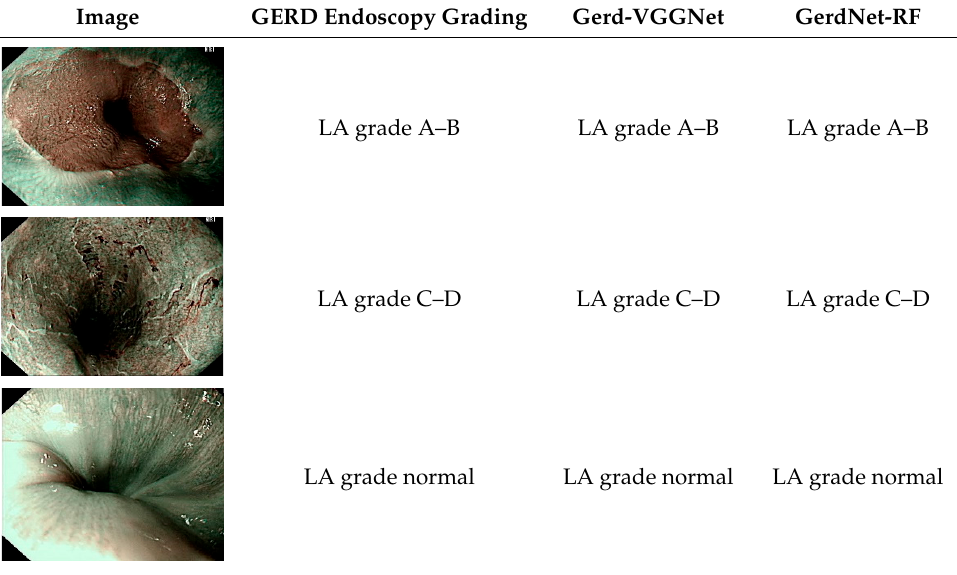
Table 7. Three types of examples where two models predict incorrectly.